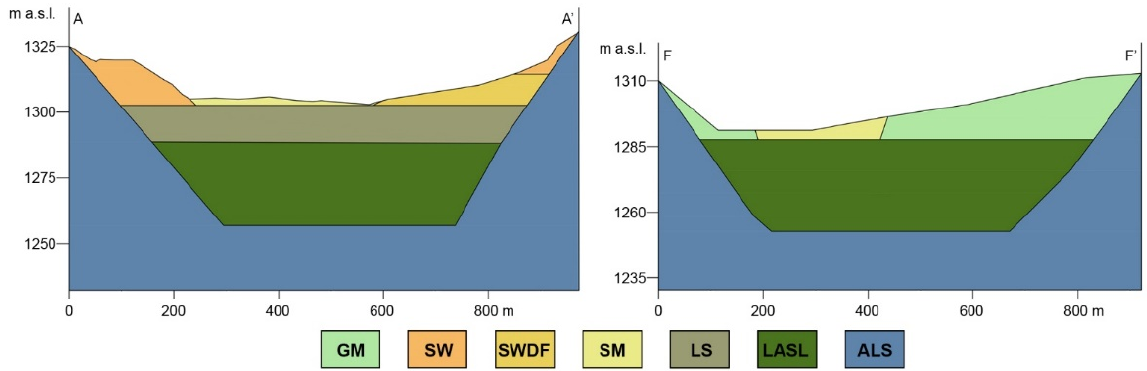
Figure 9. Engineering-geological cross-sections A–A’ and F–F’ produced for the Poggio Cancelli valley; vertical axis with 5x exaggeration with respect to horizontal axis.